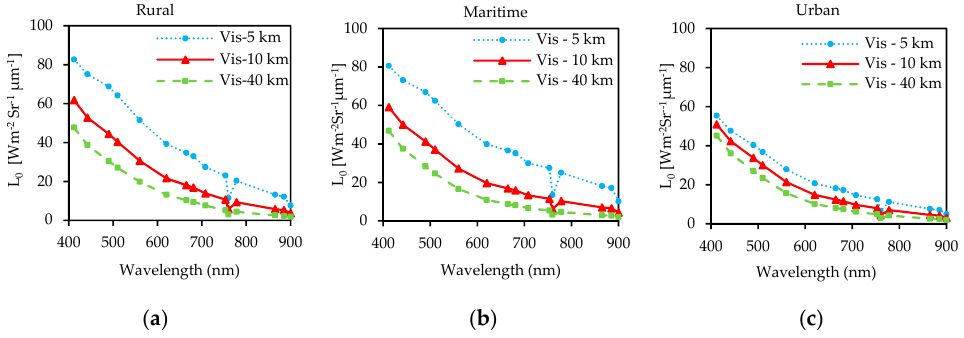
Figure 5. TOA radiance simulated by MODTRAN for ( a ) rural; ( b ) maritime and ( c ) urban aerosol types